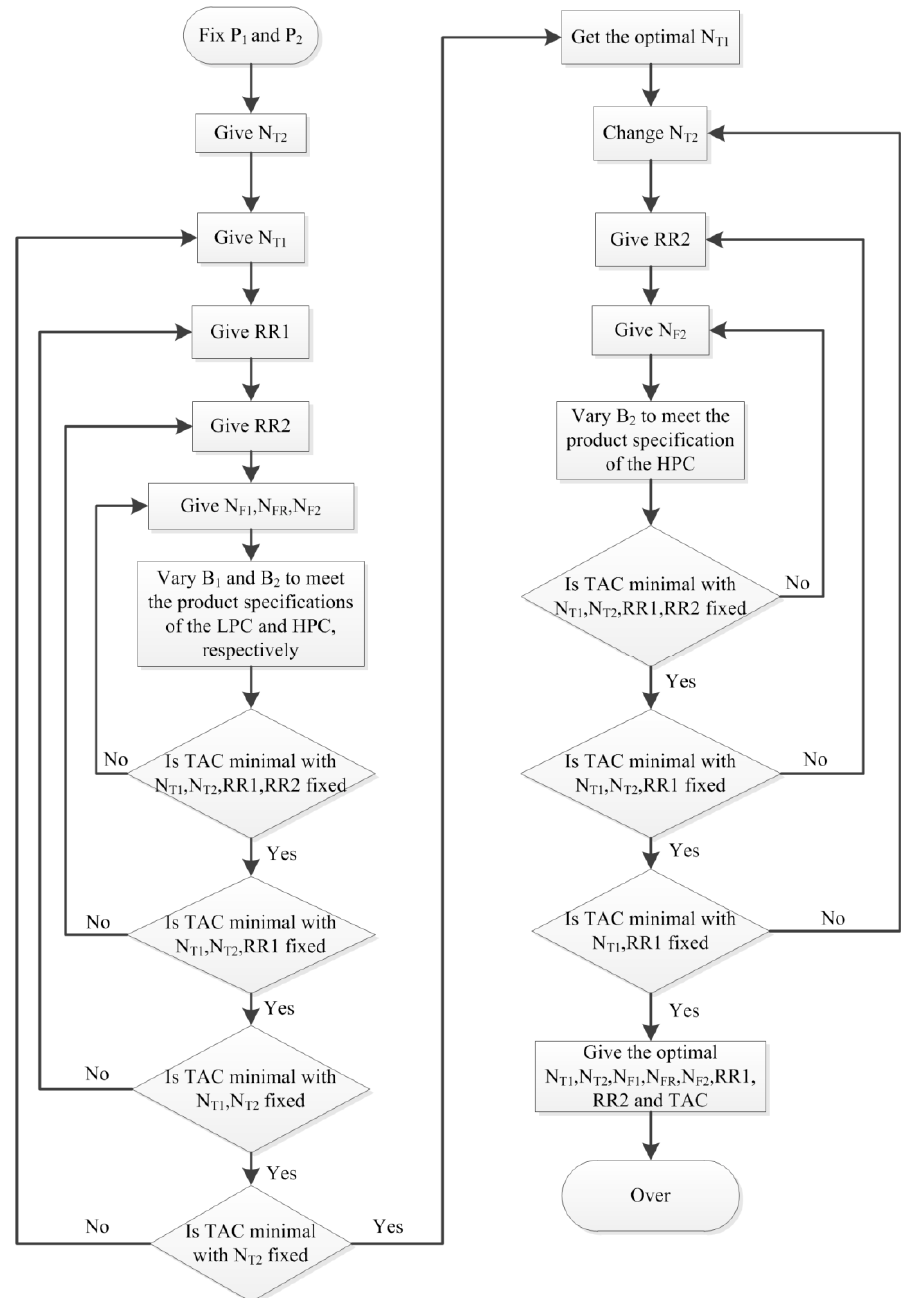
Figure 2. Optimization sequence of acetonitrile–water separation process by pressure swing distillation (PSD).